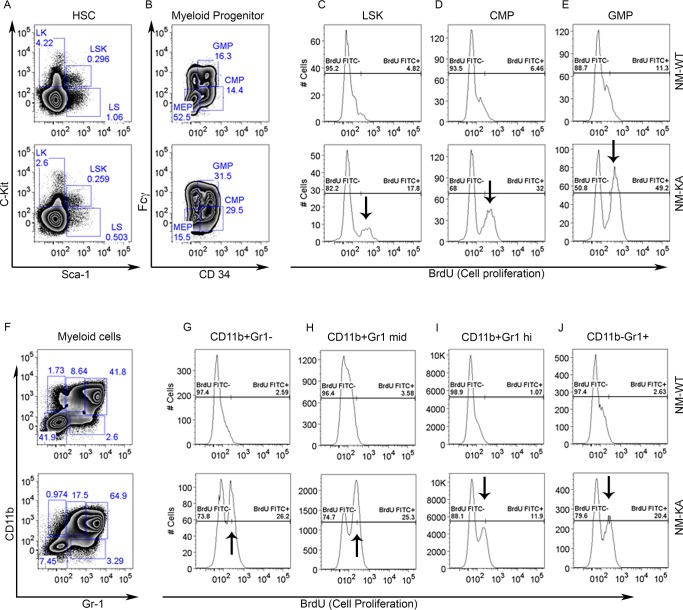
BrdU was injected to NM-WT and NM-KA mice.1 day after injection single cell suspensions from bone marrow were prepared by flushing the marrow out of femur and tibia. Following RBC lysis, cells were stained with different antibody cocktails. Flow analysis showing percentage of (A) Lin-Sca1+Kit+ (LSK) cells in haemopoietic stem cells (HSC), (B) percentage of common myeloid progenitor (CMP), granulocyte-monocyte progenitors (GMP) cells; proliferation of (C) LSK, (D) CMP and (E) GMP cells, (F) Myeloid cells and (G–J) proliferation of neutrophils populations. LysM-cre-NEMO-WT-f/f (NM-WT), LysM-cre-NEMO-K270A-f/f (NM-KA) mice.